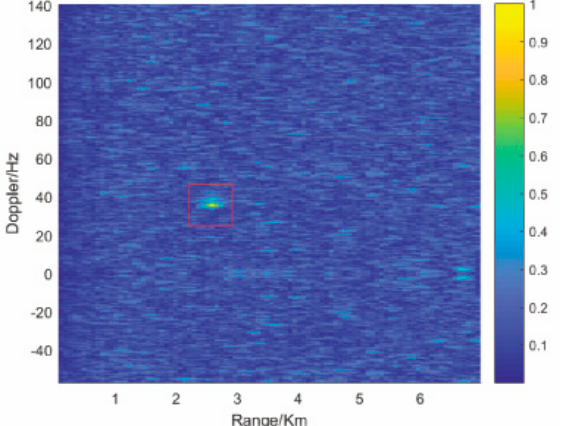
Figure 6. RD map based on modified radon Fourier transform (MFRT).